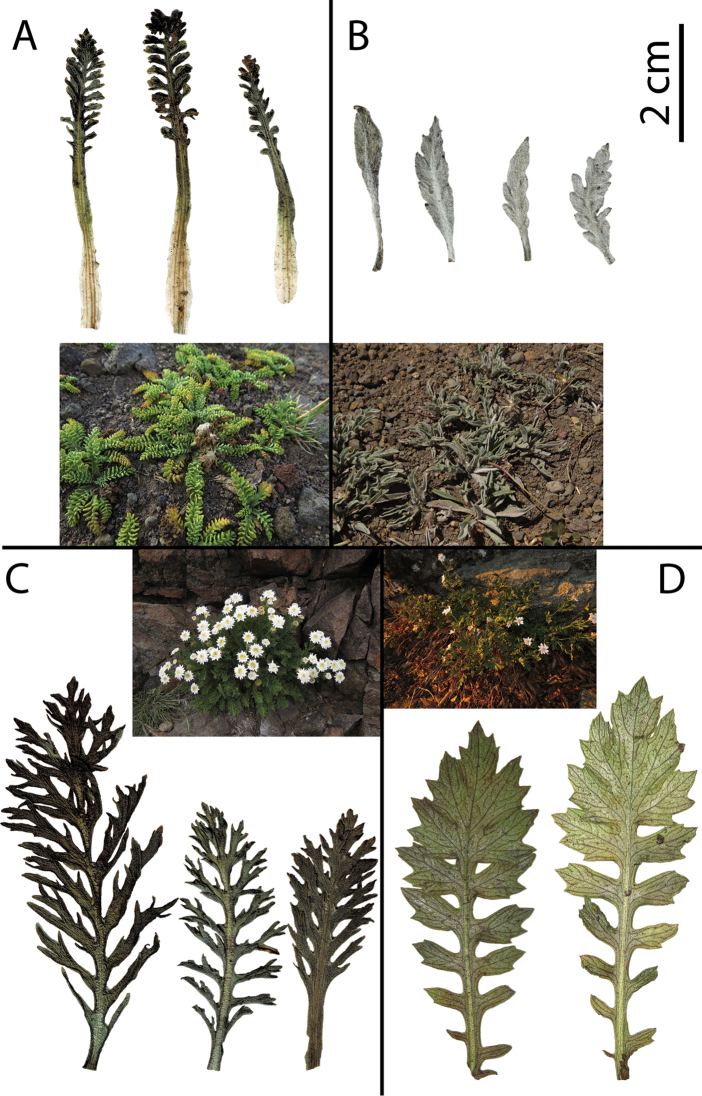
Leaf morphology and habit of acaulescent/subacaulescent Leucheria from Central Chile ALeucheria
scrobiculata (NL433, CONC), inset: Habit BLeucheria
candidissima (Lavandero, Santilli & Ossa 36, CONC), inset: Habit CLeucheria
salina (Lavandero & Abello 40, CONC), inset: Habit DLeucheria
cantillanensis (NL700, CONC), inset: Habit. All photographs by Lavandero.